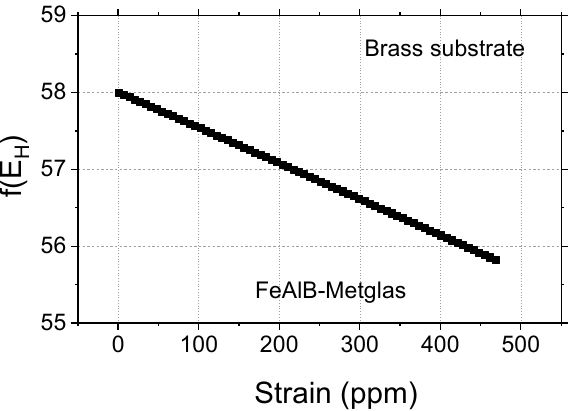
Figure 8. f ( E H ) as a function of strain. The transducer is the Fe–Al–B strip, the substrate is brass, and the resonator is a Metglas ribbon.